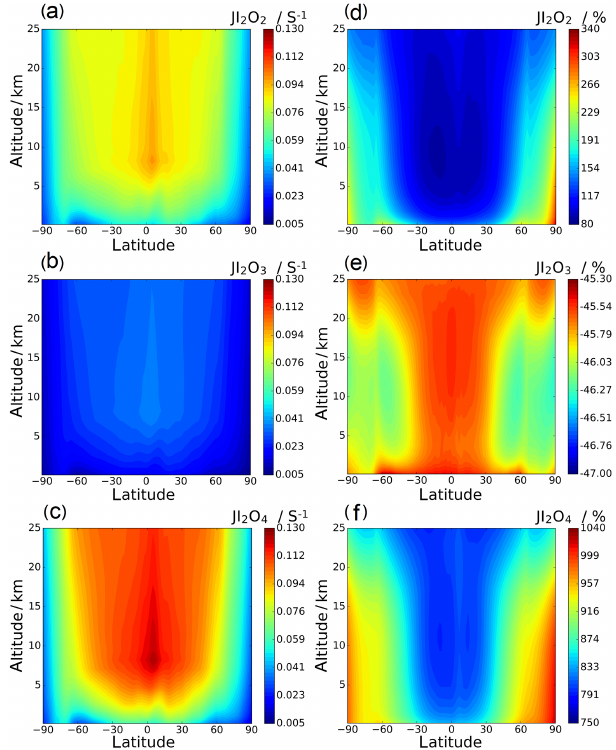
Figure 13. Annual zonal-average J value vertical profiles for I 2 O 2 , I 2 O 3 , and I 2 O 4 ( a , b , and c , respectively; note that the colour scale is the same for these three panels) and the percentage change be- tween the SL2014 annual zonal-average J value vertical profiles and the profiles in this study ( d , e , and f , respectively).